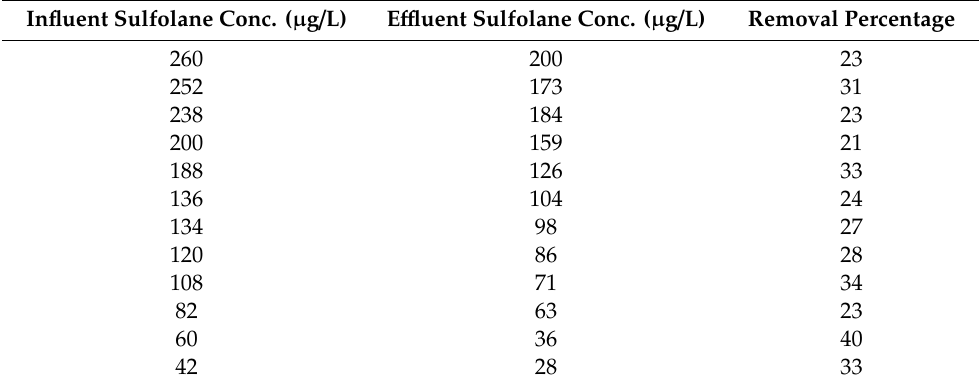
Table 2. Removal percentages for different influent sulfolane concentrations in Water I. Influent Sulfolane Conc. ( µ g / L) E ffl uent Sulfolane Conc. ( µ g /